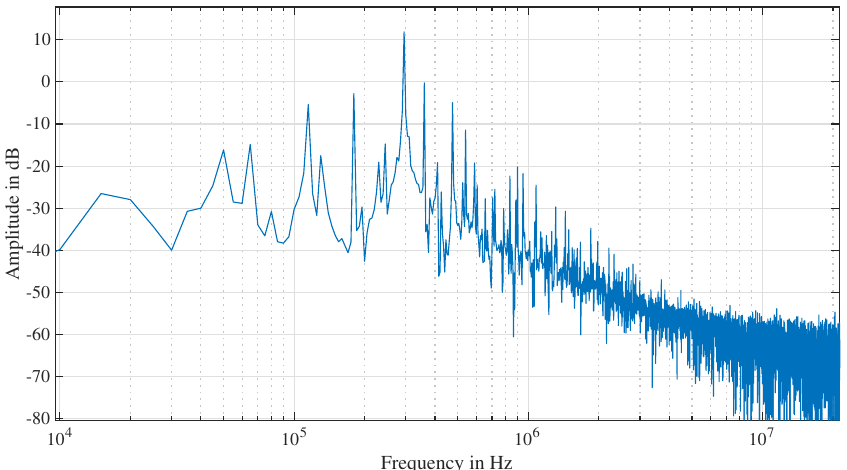
Figure 15. Fast Fourier transformation of the signal at node B ( V B ) during 200 µ s of the on-state of the Colpitts oscillator measured on our prototype.